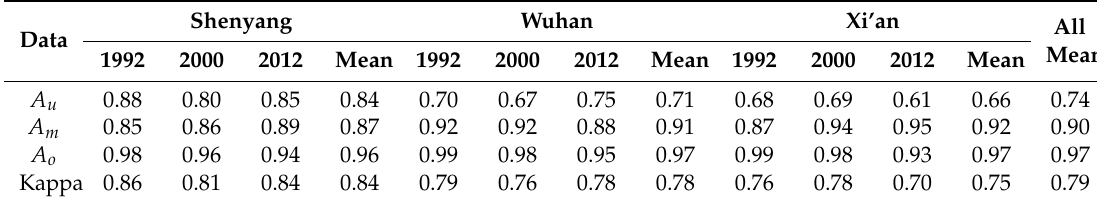
Figure 14. Comparison of model results and reference data for built-up areas. Table 9. Confusion matrix for the extraction of built-up